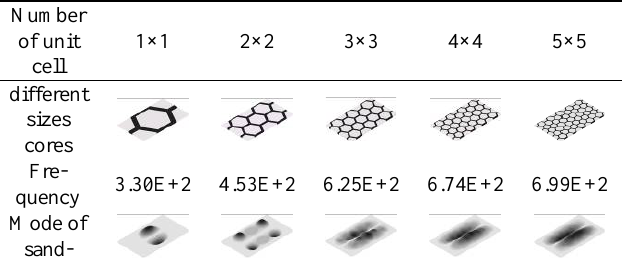
Table 11. The fourth order vibrati